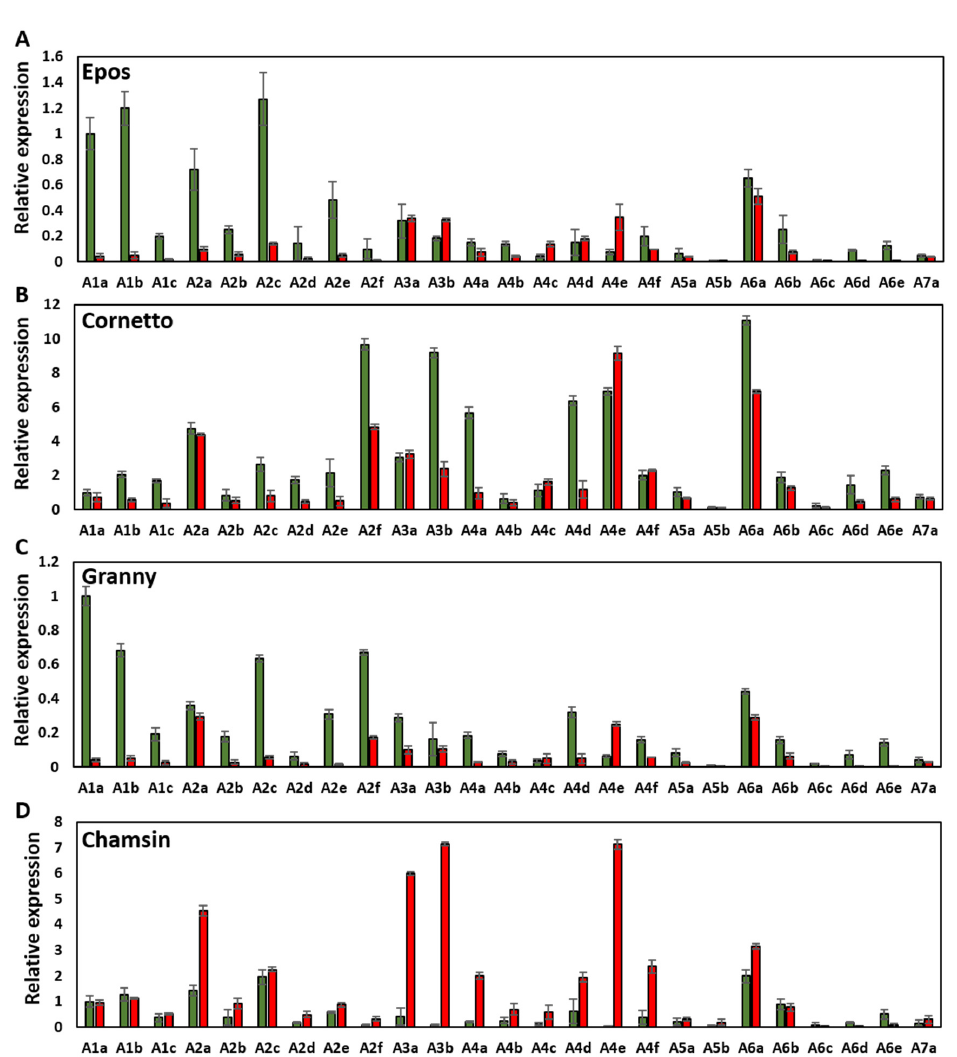
Figure 6. Relative mRNA expression levels of class A heat shock factor genes ( TaHSFs ) in anthers of European summer wheat varieties comparing heat stressed and control plants. A tubulin gene was used as housekeeping gene for normalization. Expression values were set in relation to the average expression level of A1a HSF. Epos ( A ), Cornetto ( B ), Granny ( C ), and Chamsin ( D ). Green and red bars represent non- and heat-stressed plants, respectively. Values are means ± SD of three biological